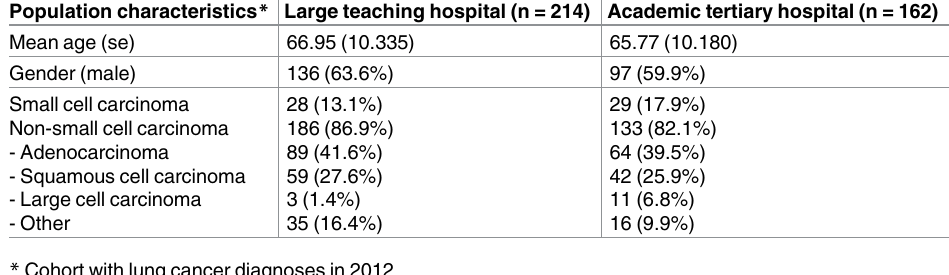
Table 1. Population